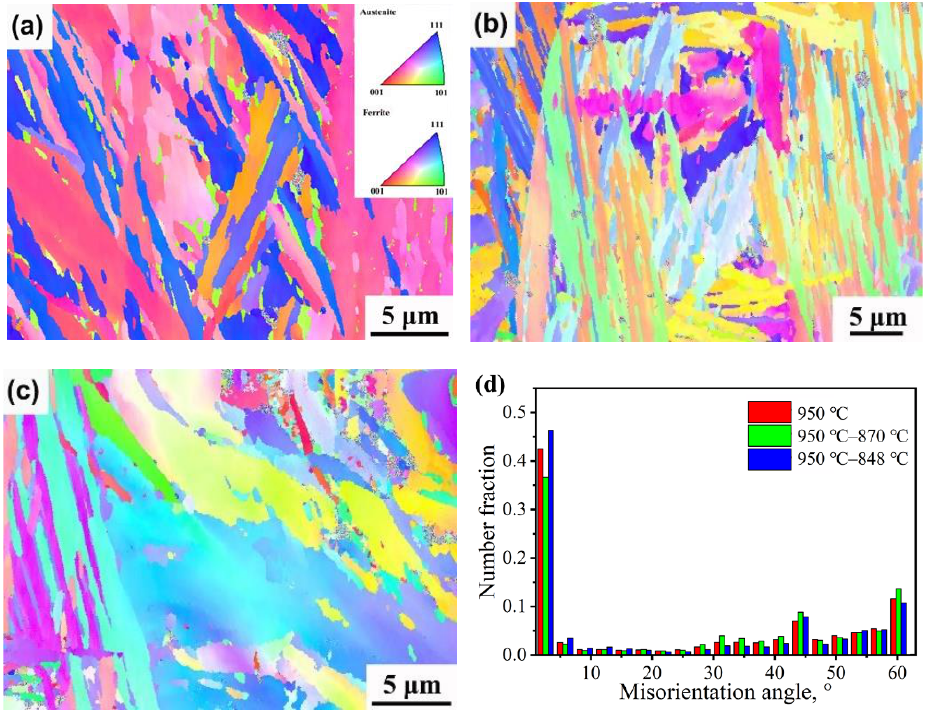
Figure 13. IPF maps (( a ) 950 °C; ( b ) 950 °C – 870 °C; and ( c ) 950 °C – 848 °C) and misorientation angle distributions ( d ) of the samples after high-temperature two-step isothermal processes.